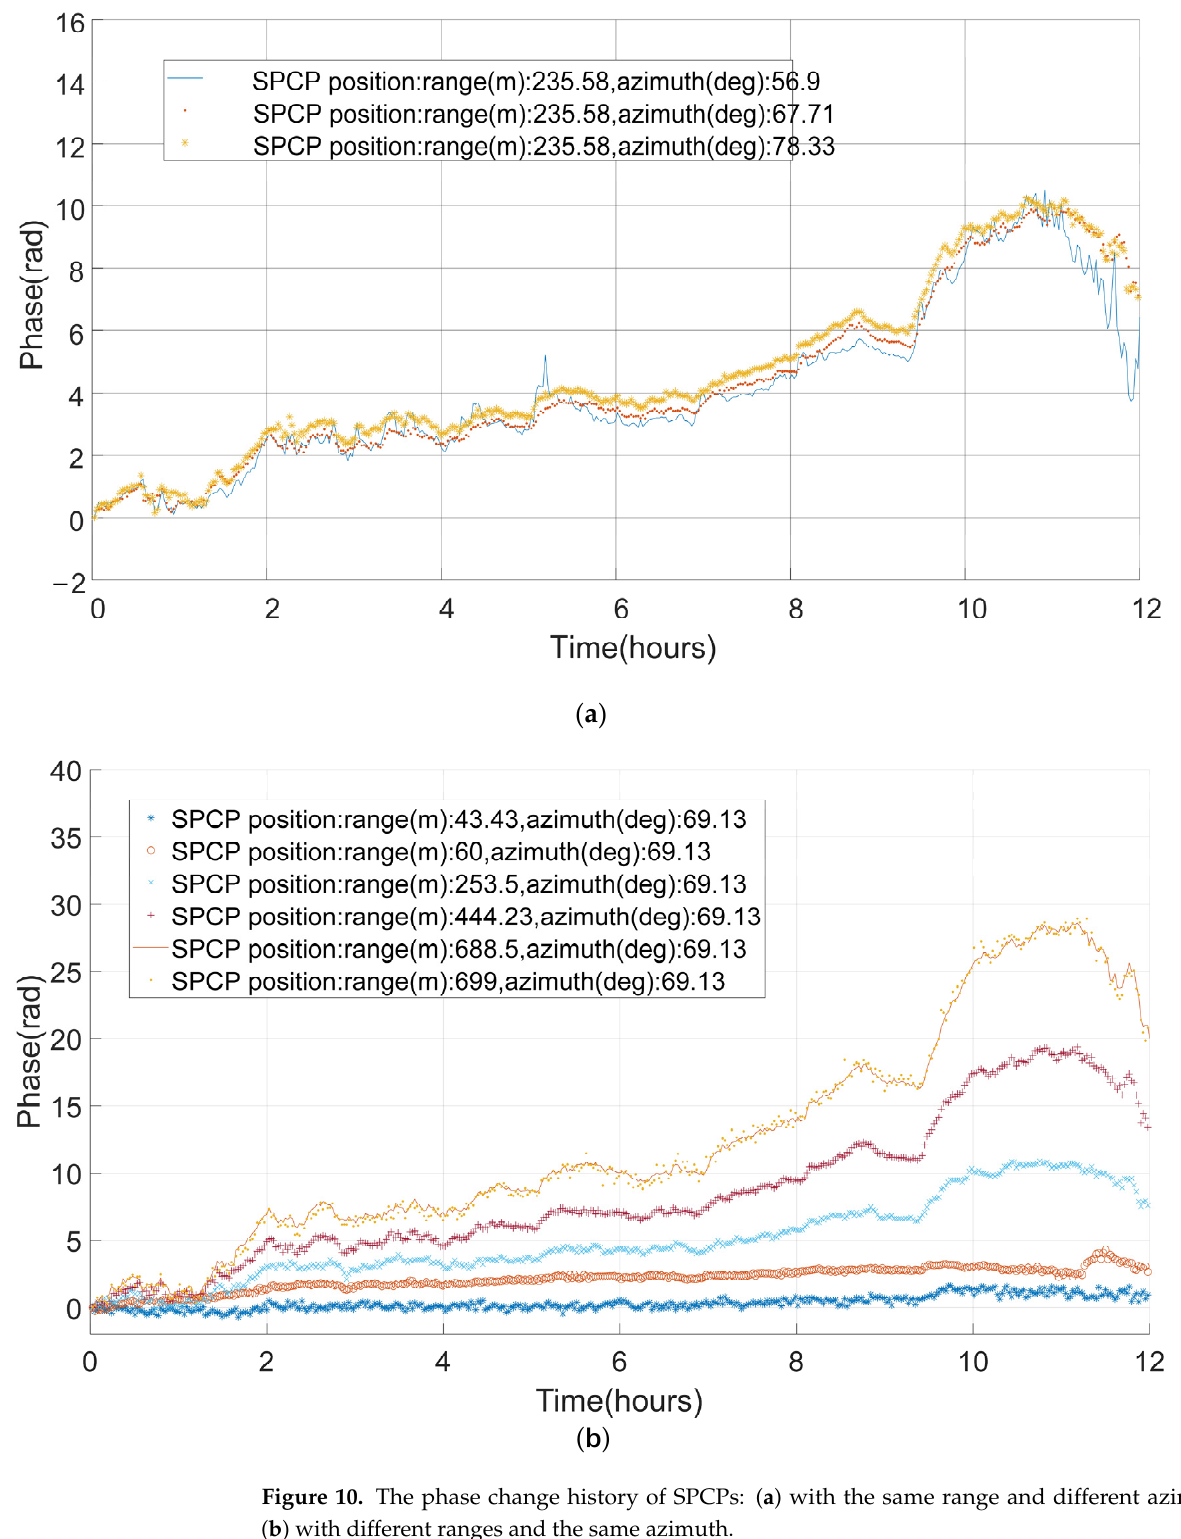
with different ranges and the same azimuth. ( b )